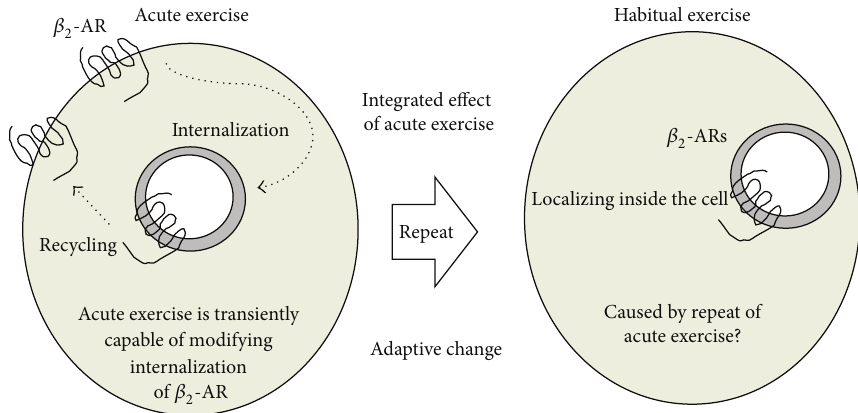
Figure 4: Internalization of 𝛽 2 -ARs from plasma membrane to intracellular space is modified by acute exercise in white adipocytes. HE- induced increase in the localizations of 𝛽 -ARs into the cytoplasm might be a result of, at least in part, a mobilization of the trafficking of 𝛽 2 -ARs, which is caused by daily repeated bouts of acute